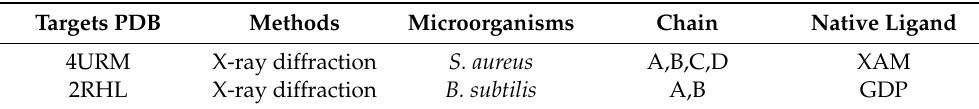
Table 8. Some information related to both S. aureus (PDB ID: 4URM) and B. subtilis (PDB ID: 2RHL) targets. Targets PDB Chain Native Ligand 4URM X-ray diffraction 2RHL X-ray diffraction B. subtilis A,B